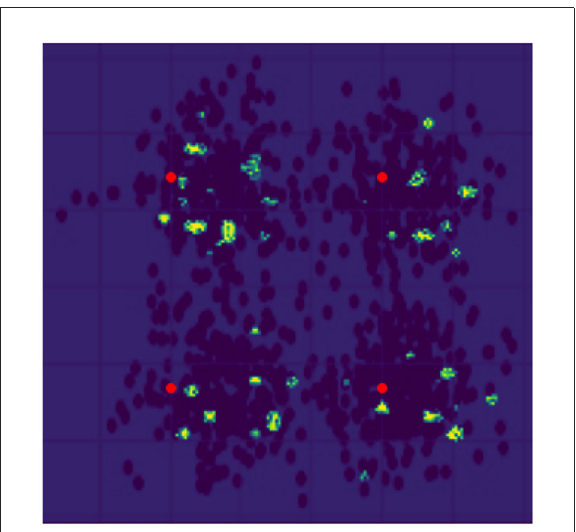
FIGURE1 Result: 4PSK. Red dots are ideal points. Yellow and Green dots represent an explanation of the prediction made by the modulation